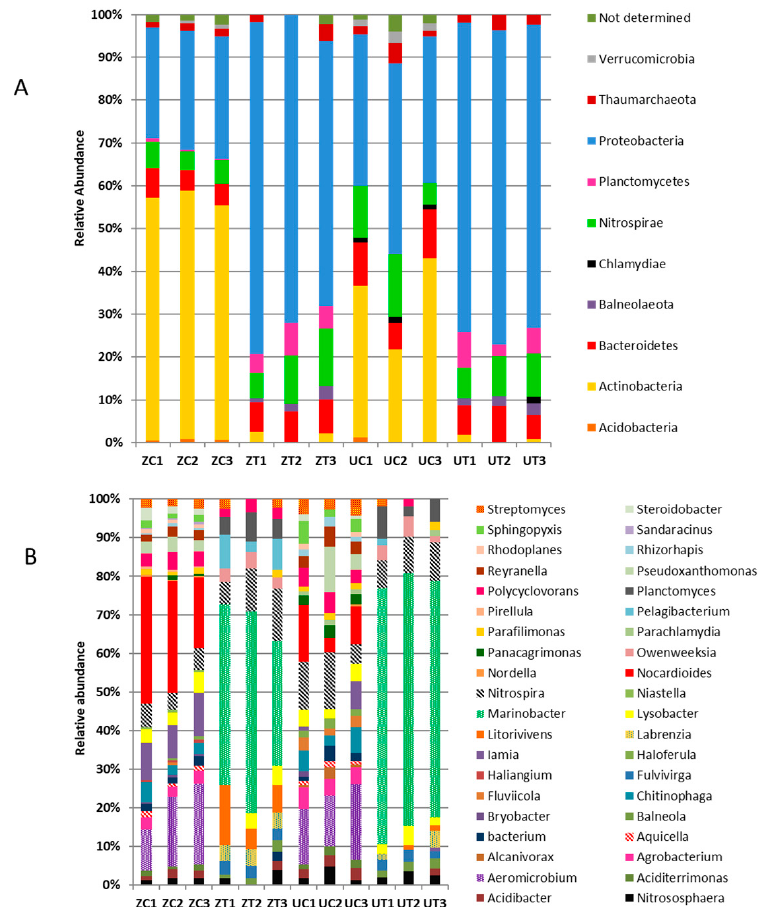
Figure 6. Relative abundance of the OTUs of the bacterial community ( A ) at the phylum level and ( B ) at the genus level of the cultivars “Umsila” (UC) and “Zabad” (ZC) when grown under control conditions and cultivars “Umsila” (UT) and “Zabad” (ZT) when grown under salinity. The abundance is expressed as the percentage of the total number of reads per OTU.